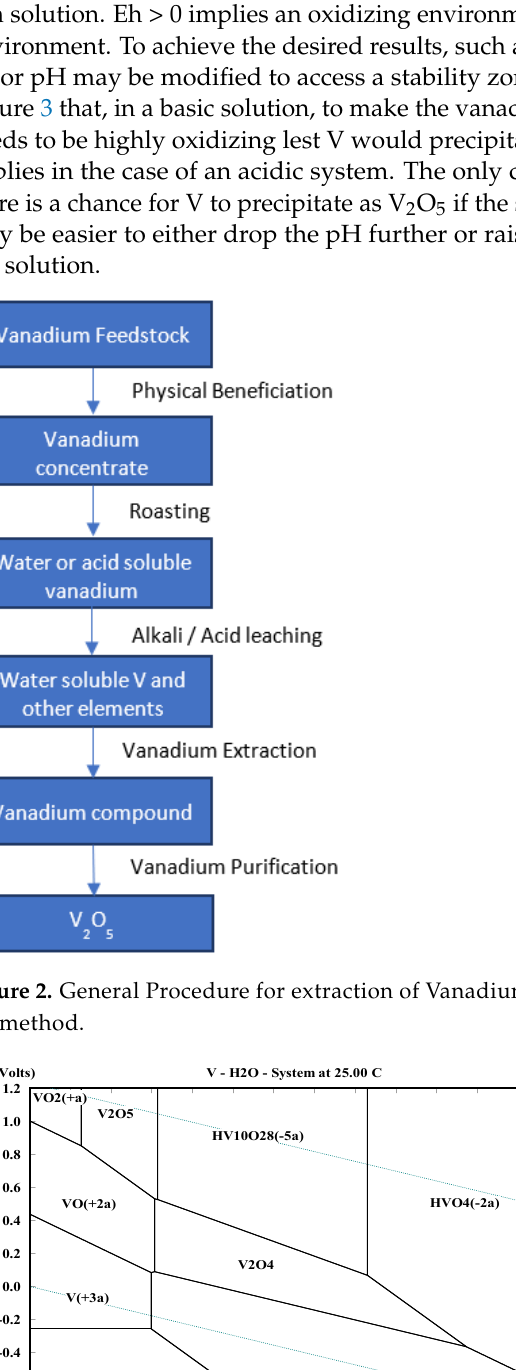
Figure 3. Pourbaix diagram for vanadium at 25 °C, 1 bar, and 10 − 2 M using HSC Chemistry.